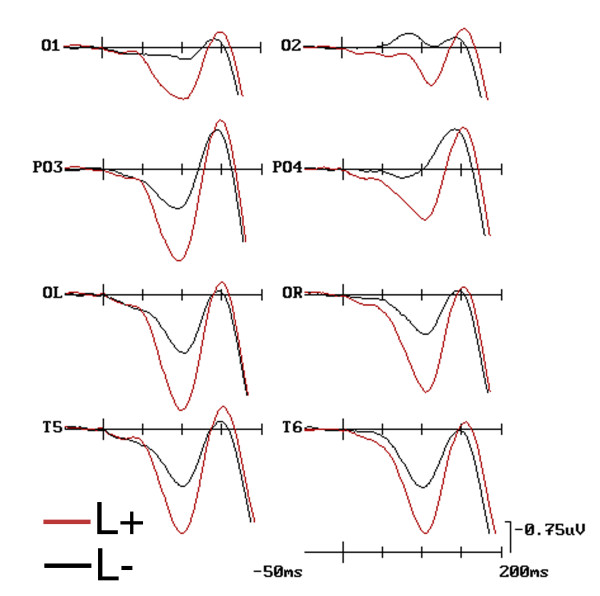
Grand-mean ERPs as obtained at left and right mesial-occipital, occipital-parietal, lateral-occipital, and temporal electrode-sites as a function of shapes location relevance (i. e., L+ and L-) collapsing data across participants, target-categories (i. e., animals and artefacts), and shape relevance conditions (i. e., S+, S+/-, and S-). Note that here only the early-latency ERP responses have been plotted with an expanded time scale of 200 ms and tick-mark progressions of 50 ms to bring out the earliness of the modulation of sensory-related C1, P1, and N1 components by spatial selective attention.